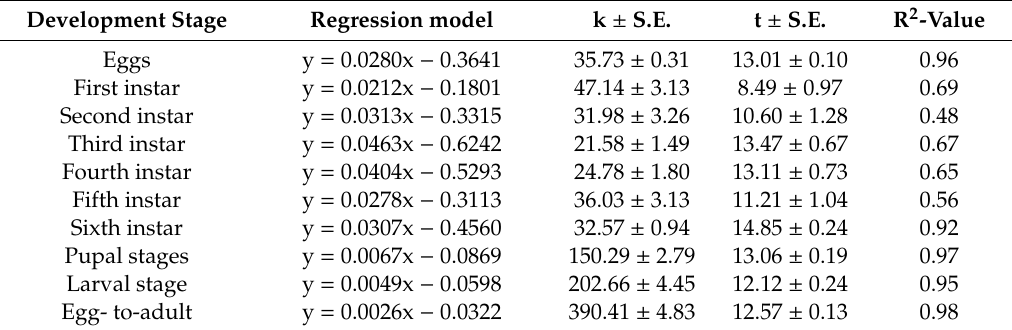
Table 2. Linear regression equations describing the relationship between the development rate (1 / days) and temperature (18–30 ◦ C) and the thermal requirements of di ff erent developmental stages of Spodoptera frugiperda .